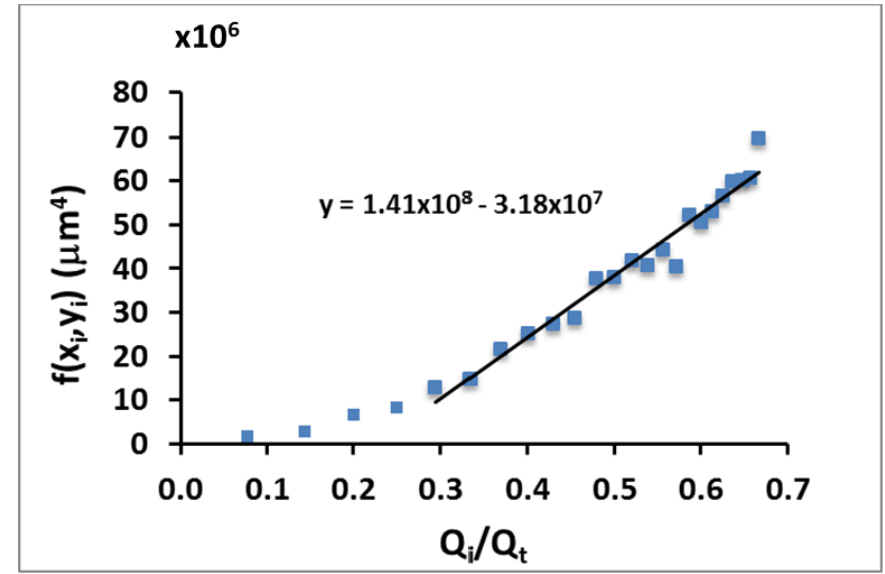
Figure 6. Plot of function f( x i , y i ) defined in Equation (3) for different values of Q i /Q t . The values of x i and y i are experimental measurements. The continuous line is the regression line of the data with a slope m exp = 1.41 × 10 8 μm 4 with an R 2 value of 9.55. The theoretical model predicted a slope of m th = 3.64 × 10 8 μm 4 .